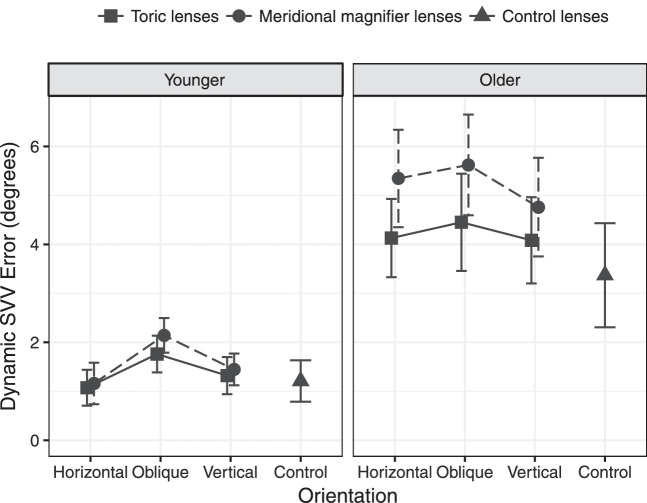
Dynamic SVV errors as a function of age group, lens type, and orientation. Error bars represent SEM.